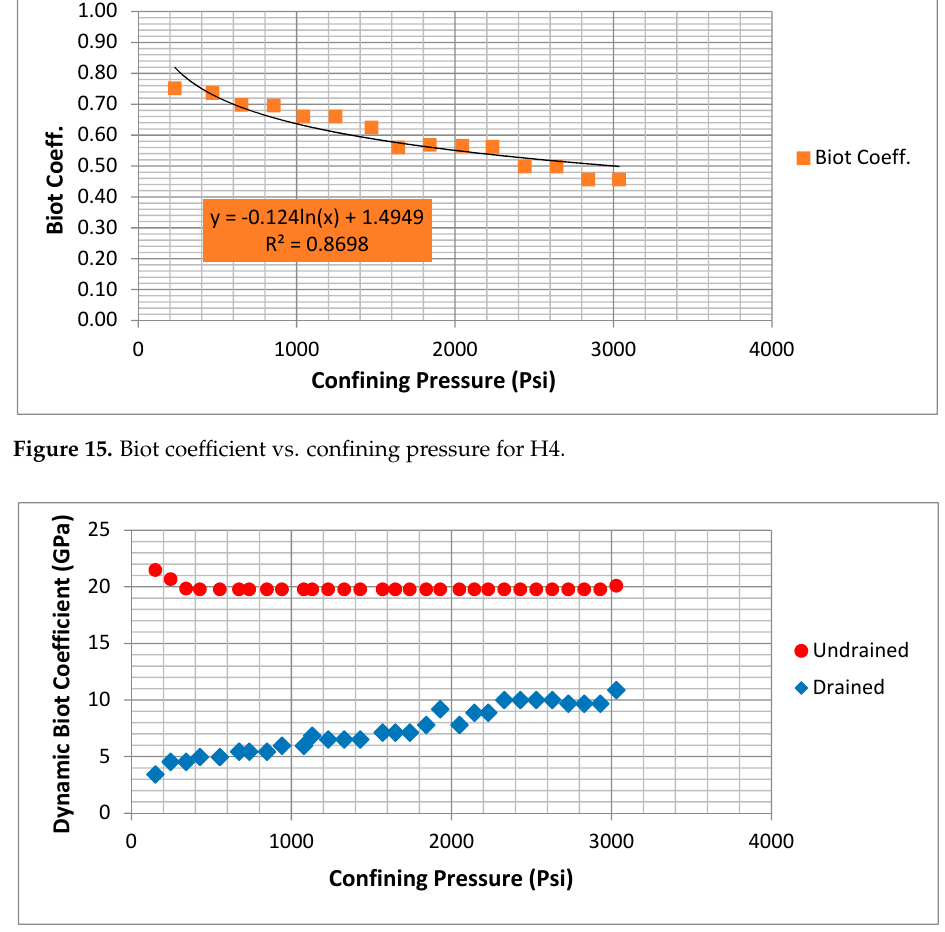
Figure 16. Undrained and drained dynamic bulk moduli vs. confining pressure for H5.